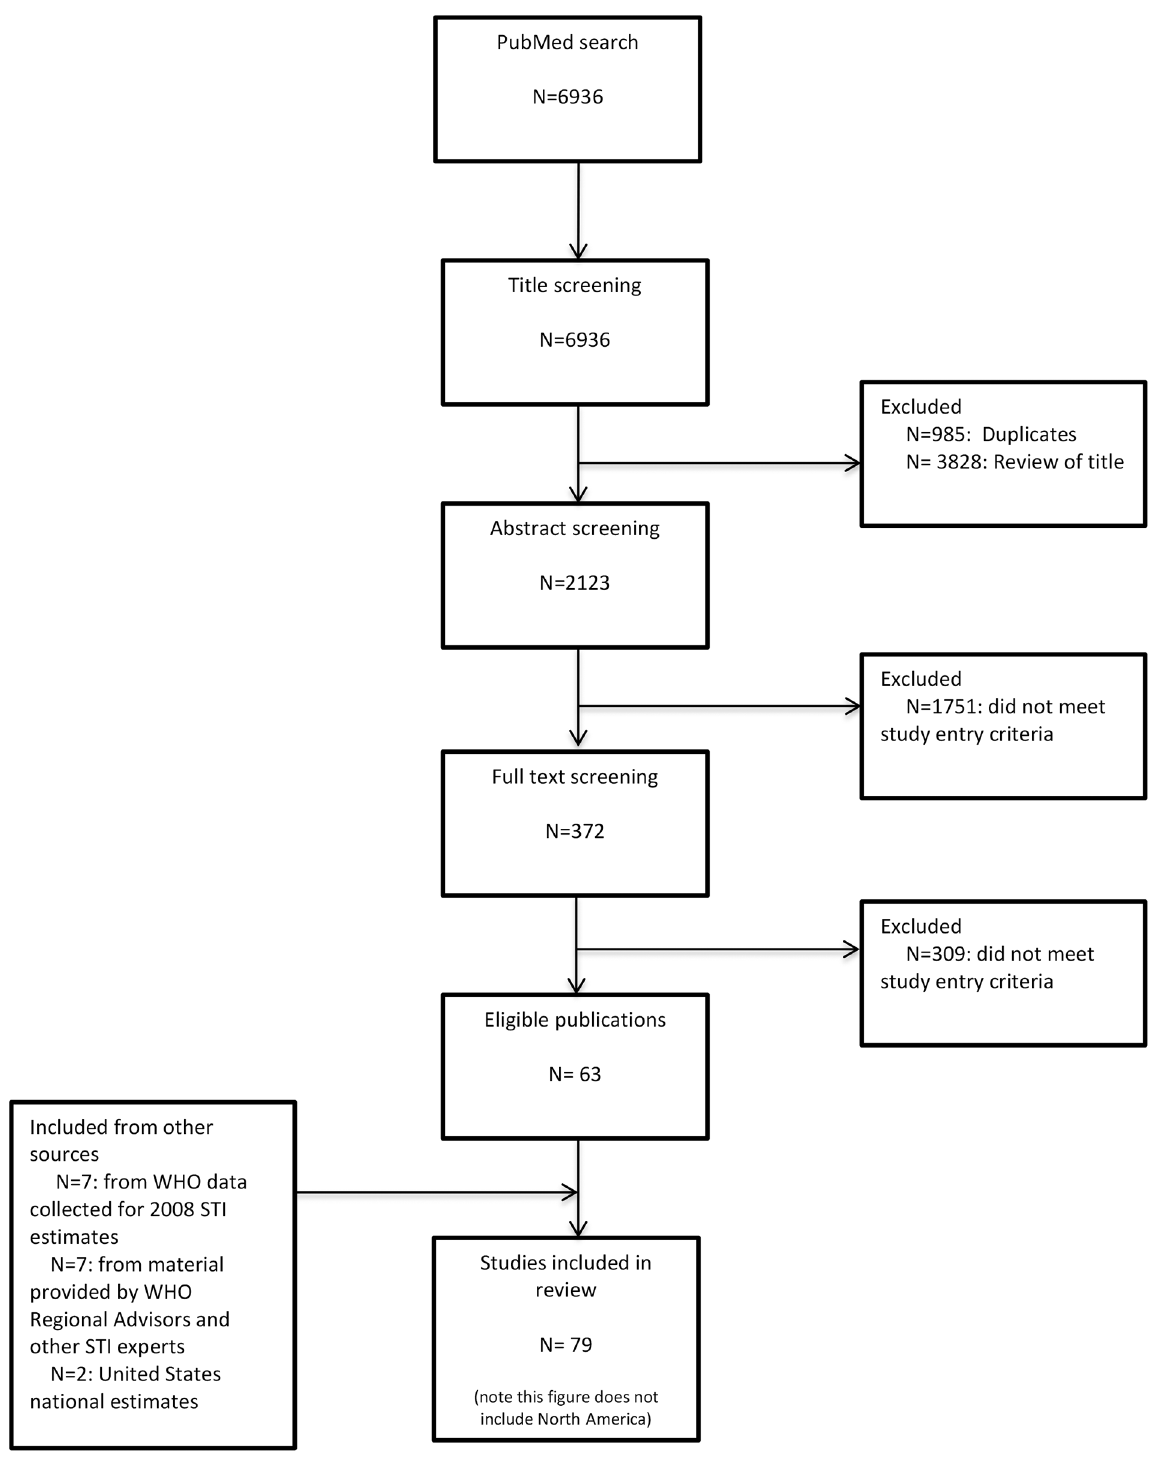
Fig 1. PRISMA flowchart.